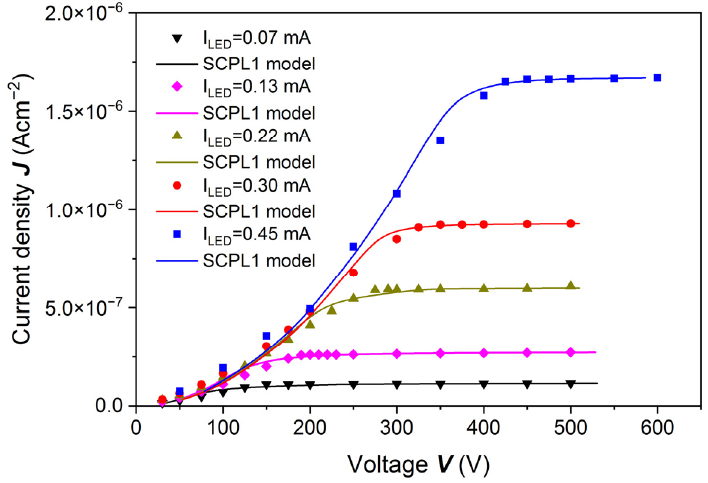
Figure 9. Current density J as a function of voltage V obtained for a (Cd,Mn)Te:In sample etched